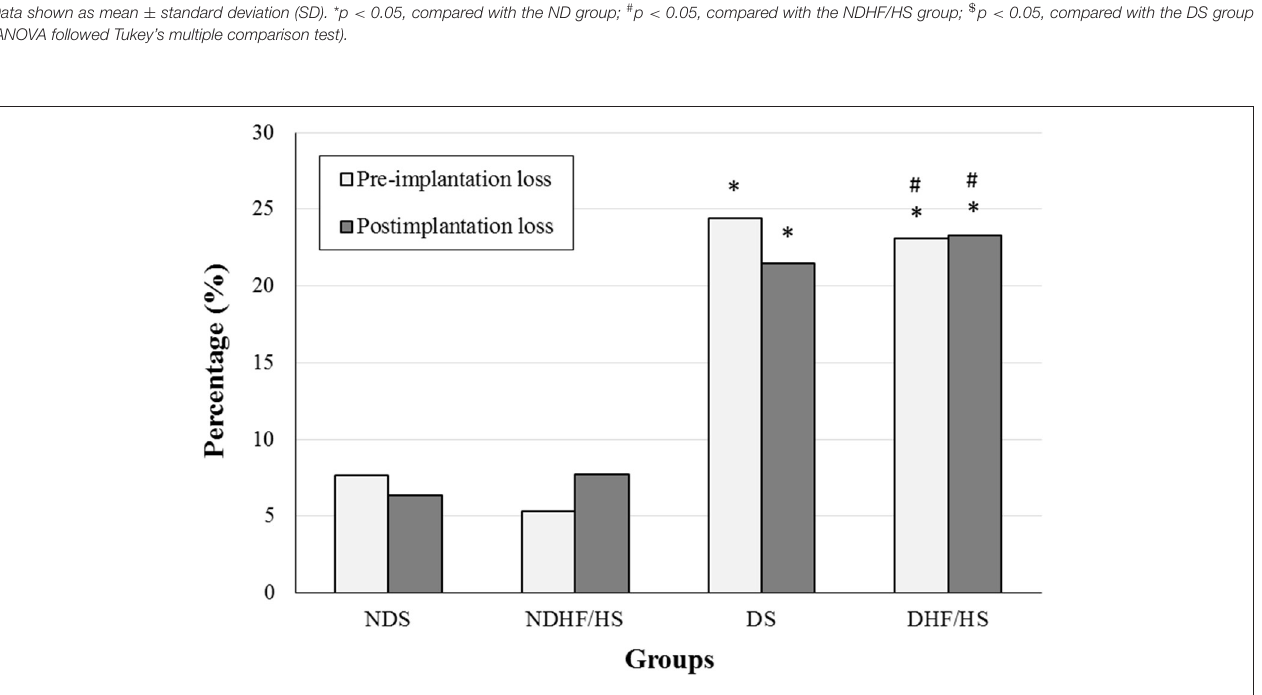
FIGURE 3 | Percentage (%) of pre- and postimplantation losses of non-diabetic (ND) and diabetic (D) rats treated or not (S), with high-fat/high-sugar diet (HF/HS) before and during pregnancy. * p < 0.05, compared with the NDS group; # p < 0.05, compared with the NDHF/HS group (Fisher’s exact test).